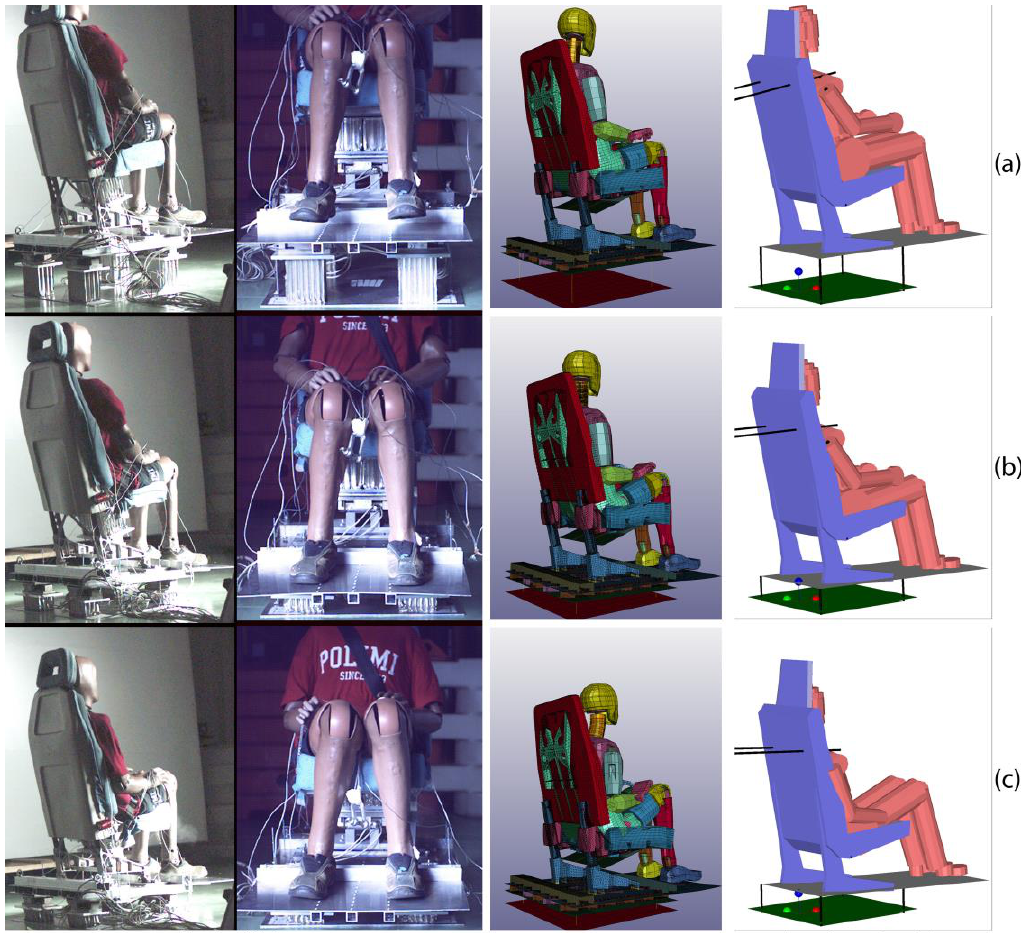
Figure 10. Relevant frames from the high-speed video: ( a ) initial impact; ( b ) end of subfloor crushing and activation of seat energy absorbers; ( c ) end of seat energy absorbers crushing.